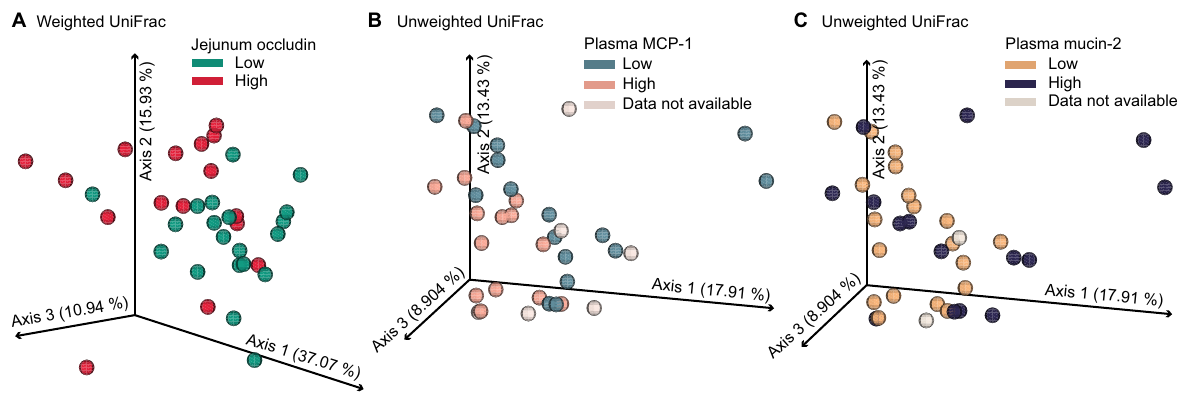
Figure 4. Changes in beta diversity of the cecal microbiome are associated with high and low expression of biological signatures of inflammation. (A) Principal coordinates ordination plot of weighted UniFrac coordinate analysis of the cecal microbiome was associated with low (pg/ml, pine green, n = 20) and high jejunum occludin concentrations (pg/ml, red, n = 16). Axis 1 explains 37.07%, axis 2 explains 15.93%, and axis 3 explains 10.94% of the variance in the microbiome data analysis such that a total of 62.94% of variance in the dataset is represented here. (B) Principal coordinates ordination plot of unweighted UniFrac analysis of the cecal microbiomes showing separation of samples with low plasma monocyte chemoattractant protein-1 concentrations (MCP-1, pg/ml) (blue-grey, n = 16) and high plasma MCP-1 concentrations (apricot, n = 14). Plasma MCP-1 data were not collected for n = 6 samples (grey). (C) Principal coordinates ordination plot of unweighted UniFrac analysis of the cecal microbiomes showing separation of samples with low (pg/ml, goldenrod, n = 19) and high plasma mucin-2 concentrations (pg/ml, deep purple, n = 15). Mucin-2 data were not collected for n = 2 samples (grey). (B,C) Principal coordinates ordination of unweighted UniFrac: axis 1 explains 17.91%, axis 2 explains 13.43%, and axis 3 explains 8.90% variance in microbiome analysis such that a total of 40.24% of the variance in the dataset is represented here. MCP-1 monocyte chemoattractant However, composition of the cecal microbiome as assessed by weighted UniFrac was correlated with jejunum occludin levels in such a way that low concentrations of jejunum occludin clustered around axes 1 and 2 ( pseudo- F = 4.22, p = 0.001; Fig. 4A). In addition, the composition of the cecal microbiome as assessed by unweighted UniFrac distance metric was associated with plasma MCP-1 concentrations, with a low plasma MCP-1 cluster around axis 2 and a high plasma MCP-1 cluster around axis 3 ( pseudo-F = 1.87, p = 0.019; Fig. 4B). Finally, com- position of the cecal microbiome as assessed by unweighted UniFrac distance metric was associated with plasma mucin-2 concentrations, with low mucin-2 concentrations associated with ordinal clustering around axes 2 and 3 ( pseudo-F = 1.64, p = 0.043; Fig. 4C).